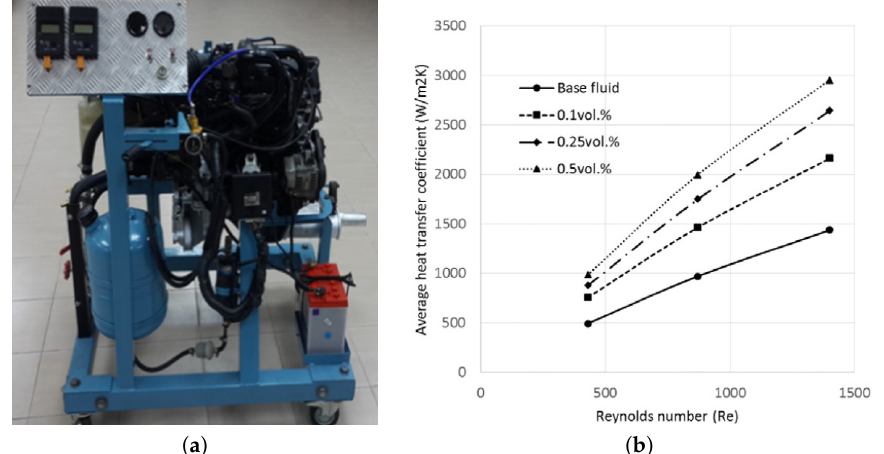
Figure 6. ( a ) Photograph of a real car radiator setup; ( b ) heat transfer coefficient at different Reynolds numbers and volume fractions of MWCNT in a water-ethylene-glycol mixture (50:50). After [17], with permission from